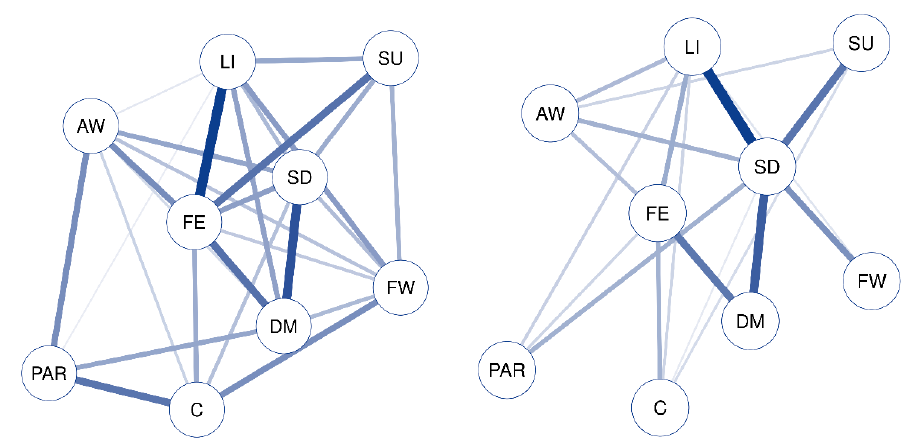
Figure 3. CIDI65 + symptoms network for age groups (age group 65–74 and age group 75–84). Each node represents an item, and each link represents a relation between each pair of items (bolder lines indicate stronger relations). DM: depressed mood; LI: loss of interest or pleasure; AW: appetite or weight disturbance; SD: sleep difficulties (insomnia or hypersomnia); PAR: psychomotor agitation or retardation; FE: fatigue or loss of energy; FW: feelings of worthlessness or guilt; C: diminished ability to think or concentrate; SU: suicidality . Table 4. Centrality measures for CIDI65+ items by age groups.